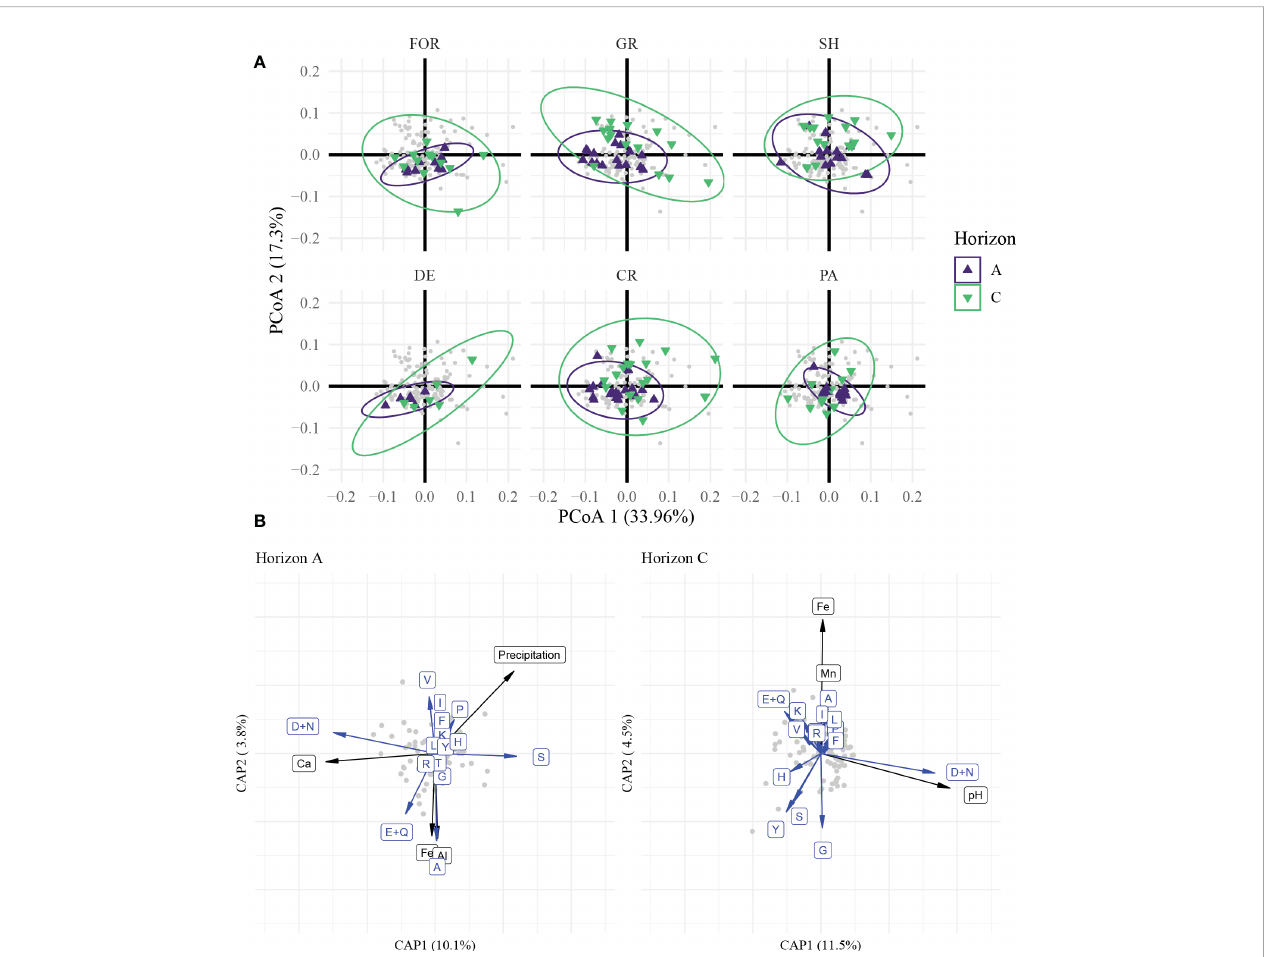
FIGURE 4 Molecular diversity and environmental factor changes under the in fl uence of selective decomposition of HAAs during pedogenesis, revealed by multidimensional sorting. (A) PCoA-based sorting on the molar ratio of HAAs. Samples from different vegetation types were exhibited separately. Colors represent different soil layers. FOR, evergreen or mixed forest; GR, grassland/herbaceous; SH, shrubland; DE, deciduous forest; CR, small grains or crop; PA, pasture/hay. Samples from fallow or low intensity residential are not shown here due to the small sample size. (B) Driving factors of HAAs in different soil layers exhibited by dbRDA. A-horizonal and C-horizonal samples were fi tted separately to compare the changes in environmental factors. The single letters in blue represent the corresponding amino acids. A, Ala; R, Arg; G, Gly; H, His; I, Ile; L, Leu; K, Lys; M, Met; F, Phe; P, Pro; S, Ser; T, Thr; Y, Tyr; V, Val; D, Asp; N, Asn; E, Glu; Q, Gln. Black labels represent speci fi c environmental factors. Data were transformed by log1p (HAAs) or log (environmental